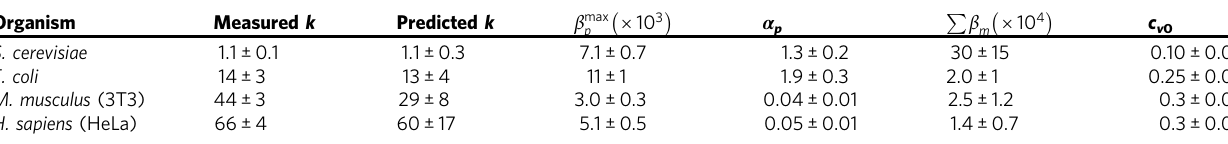
Table 1 The intercept k of the boundary of the depleted region varies over two orders of magnitude across the studied organisms Organism Measured k Predicted k β max